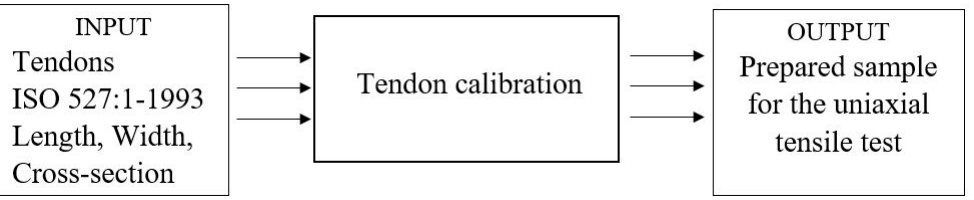
Figure 2. The black box of the functional structure.